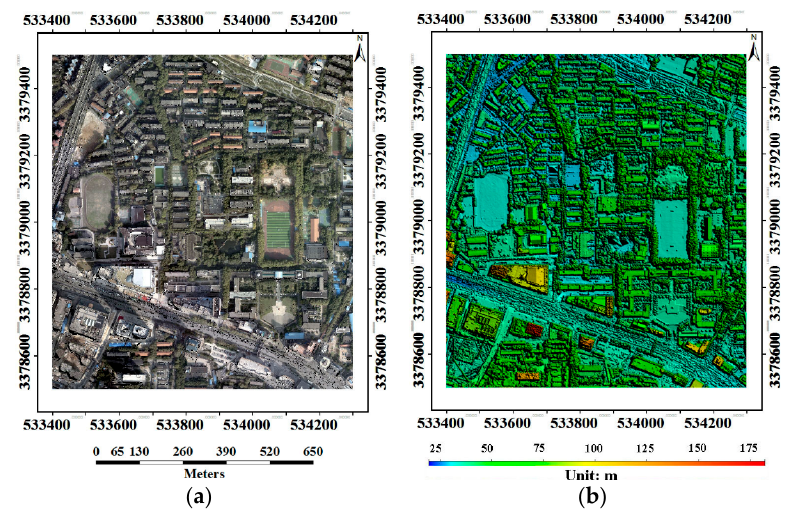
Figure 9. The Main experimental data: ( a ) overview of Wuhan University; and ( b ) DSM interpolated with LiDAR which was used as the reference data.